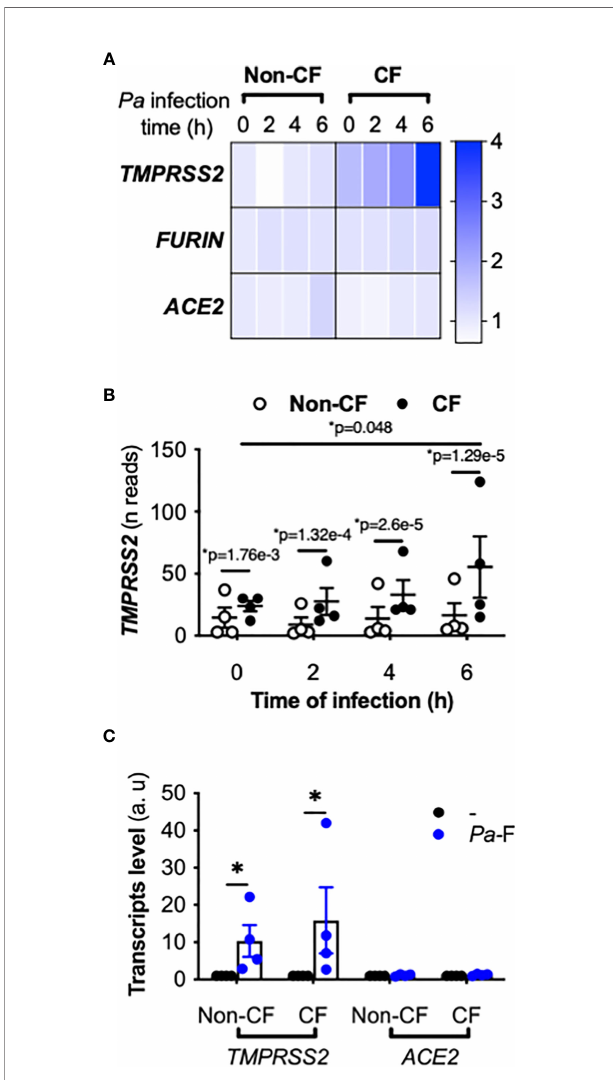
FIGURE 1 | Effect of P. aeruginosa infection on ACE2 , TMPRSS2 , and FURIN expression in primary hAECs. Heatmap of ACE2 , TMPRSS2 , and FURIN expression (fold-change) (A) and kinetics of TMPRSS2 expression (shown in reads) (B) in primary hAECs isolated from non-CF and CF patients and infected with P. aeruginosa (multiplicity of infection = 0.25) [RNA-seq data extracted from a previous study (17), Benjamini-Hochberg adjusted p value (*p)]. (C) ACE2 and TMPRSS2 mRNA expression (in arbitrary units, a.u.) in submerged non-CF (n=4) and CF (n=4) primary hAECs stimulated with control medium (reference group) or Pa -F (50 ng/mL) for 6 h (ANOVA with Bonferroni ’ s multiple- comparison test, * P <